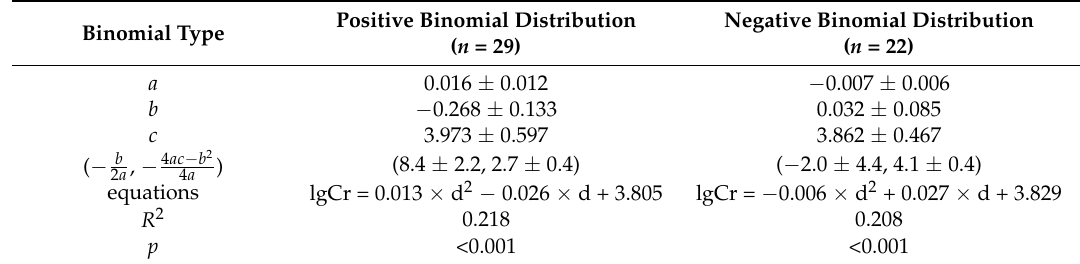
Table 3. Fitted binomial regressions of lgCr to depth ( d ) in the form of y = ax 2 + bx + c ). Binomial